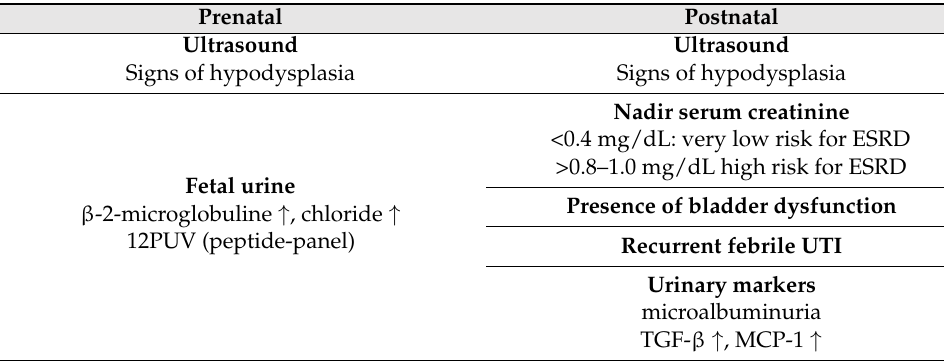
Table 1. Most relevant prenatal and postnatal risk factors for chronic kidney disease